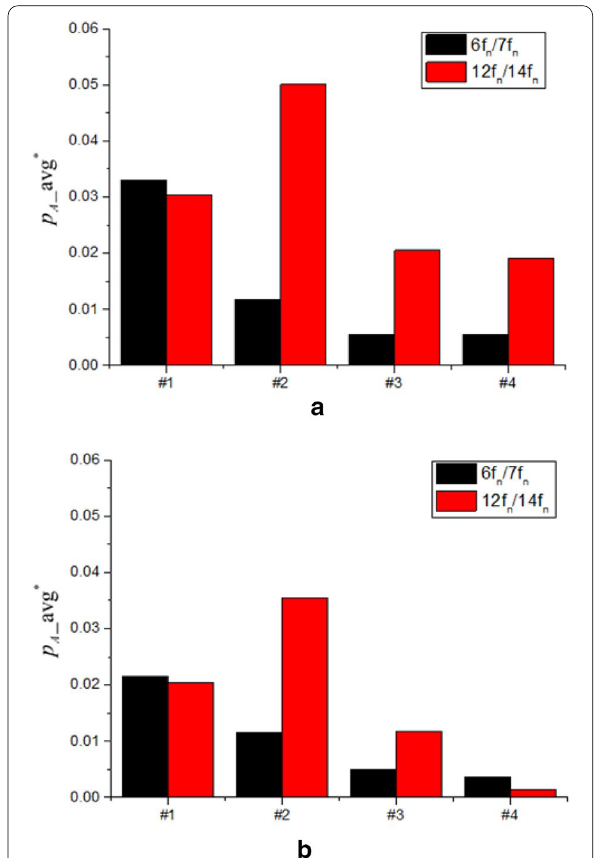
Figure 11 Average of the dimensionless pressure fluctuation amplitude in the four models: a on monitoring points P1 ‒ P8 in the impeller; b on monitoring points V1 ‒ V8 in the volute